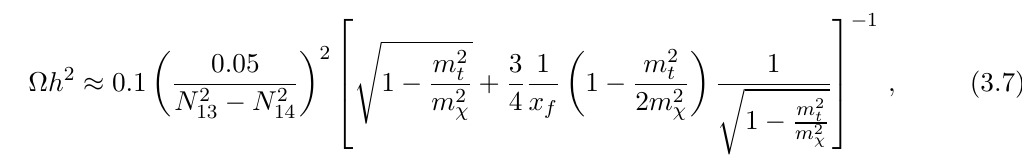
Figure 2 . Contour lines of (cid:10) h 2 = 0 : 10 ; 0 : 12 ; 0 : 14 as functions of m LSP and j N 2 LSP mass regimes (blue and red dashed lines in the left plot were obtained from eq. (3.6) whereas dotted lines in the right plot from eq. (3.7)). Yellow area is forbidden because of eq. (3.9). Grey color in the left plot denotes the regions in which h resonance and W + W (cid:0) =Z 0 Z 0 channels may be important and a(cid:11)ect the results. Green/cyan areas correspond to LUX/IceCube limits on spin- dependent LSP interaction with nucleons [41], [51]. Dashed (continuous) green lines in both plots correspond to the precision of the future XENON1T (LZ) experiment of SD direct interaction of the LSP with neutrons